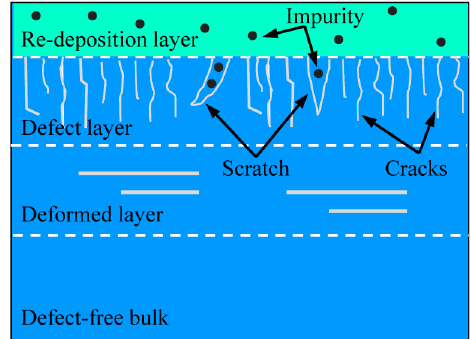
Figure 2. Schematic of the subsurface damage (SSD) defect distribution located beneath the ground and polished fused silica surface.